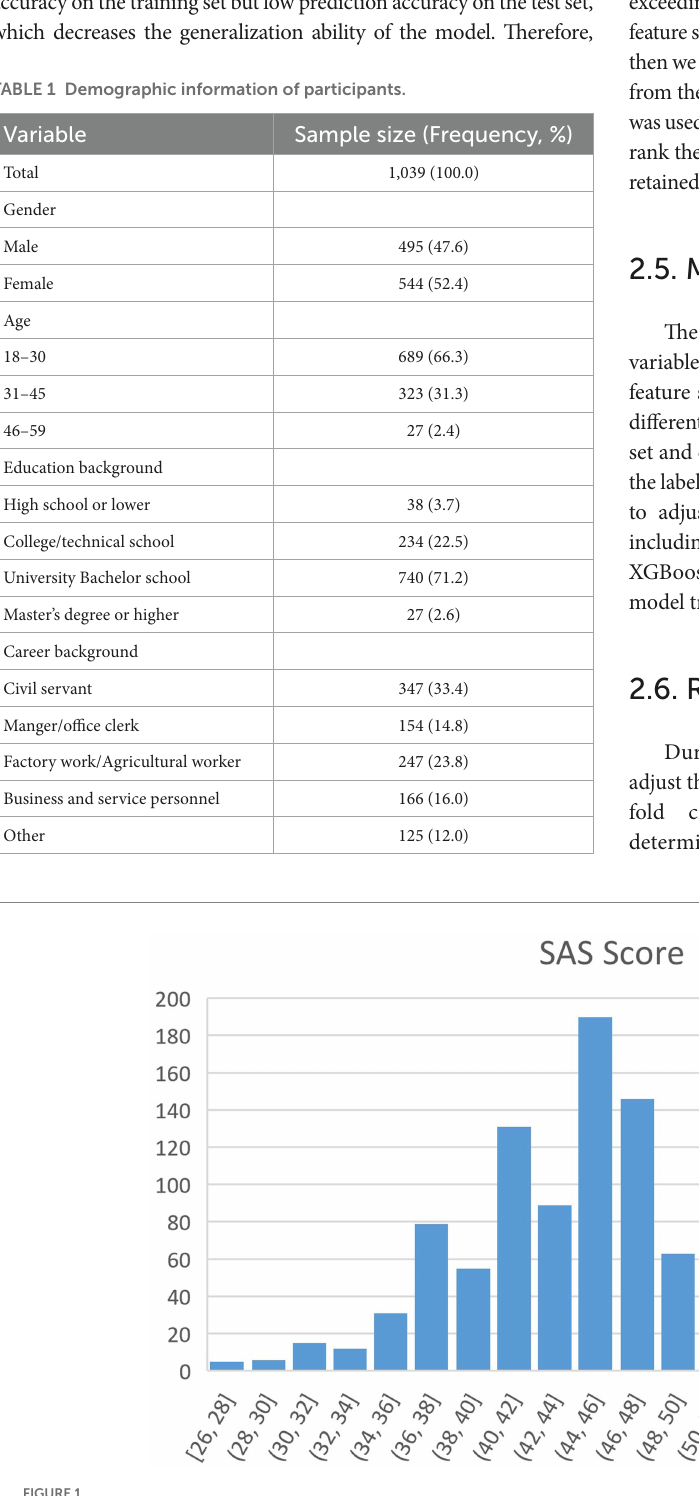
FIGURE 1 The distribution of SAS